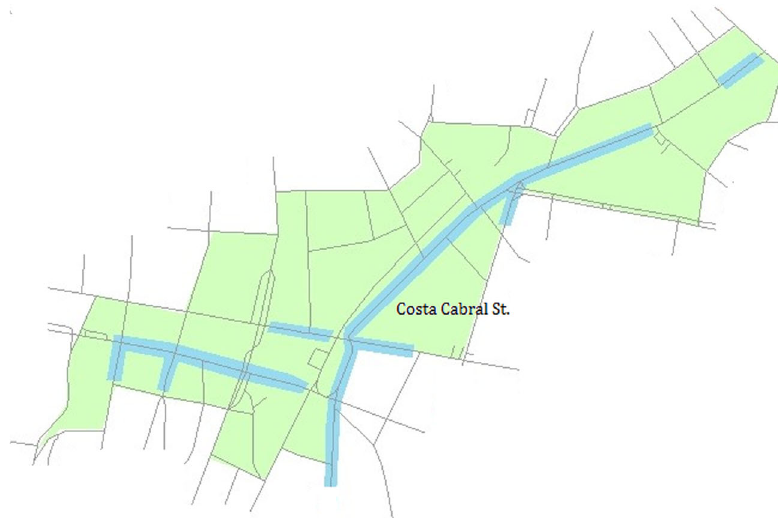
Fig. 1 Layout of the test network in the city of